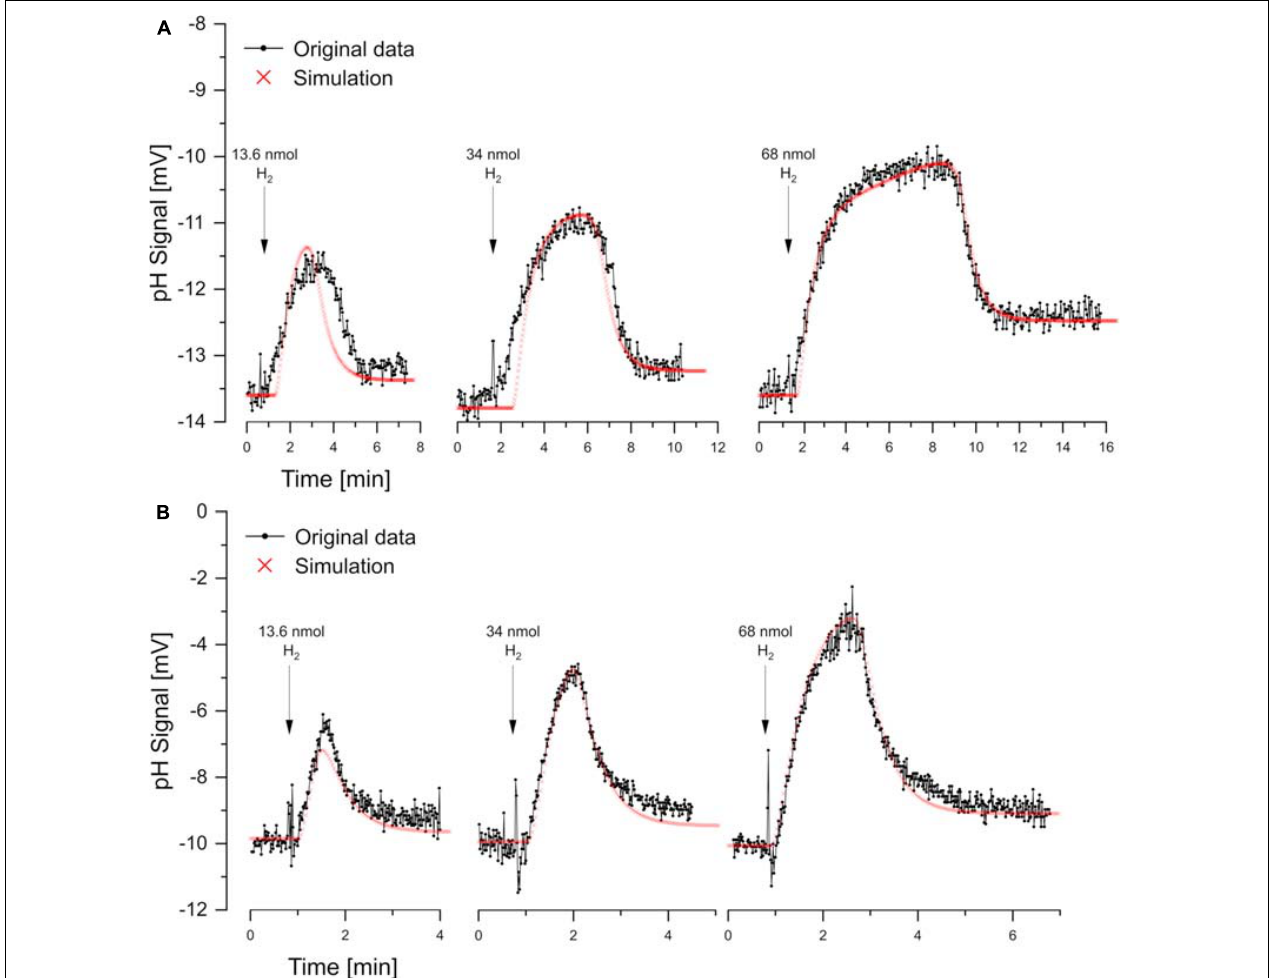
FIGURE 5 | Reductant pulse experiments. Proton translocation induced by H 2 pulses to cell suspensions incubated in N 2 -saturated KCl with KSCN (100 mM) and (A) sulfate-grown cells with 10 mM Na 2 SO 4 or (B) nitrate-grown cells with 10 mM NaNO 3 . Three different H 2 concentrations were added for each electron acceptor. Correspondingly the simulations by proton.exe differ only by the amounts of electron donor added (parameters see Supplementary Material , standard deviations see Supplementary Table 1